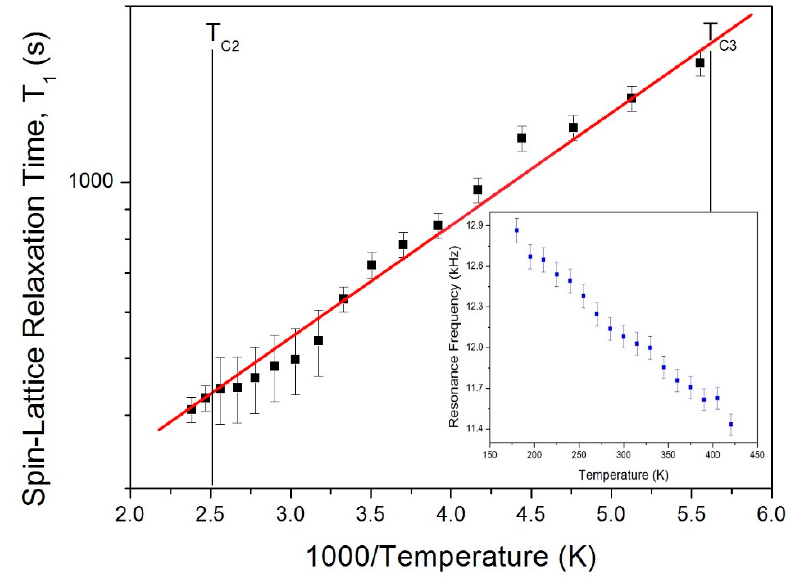
Figure 7. Spin–lattice relaxation times in the laboratory frame T 1 for 113 Cd in (C 3 H 7 NH 3 ) 2 CdCl 4 crystals vs. 1000/T. Inset: Resonance frequency of 113 Cd in (C 3 H 7 NH 3 ) 2 CdCl 4 crystals at different temperatures.